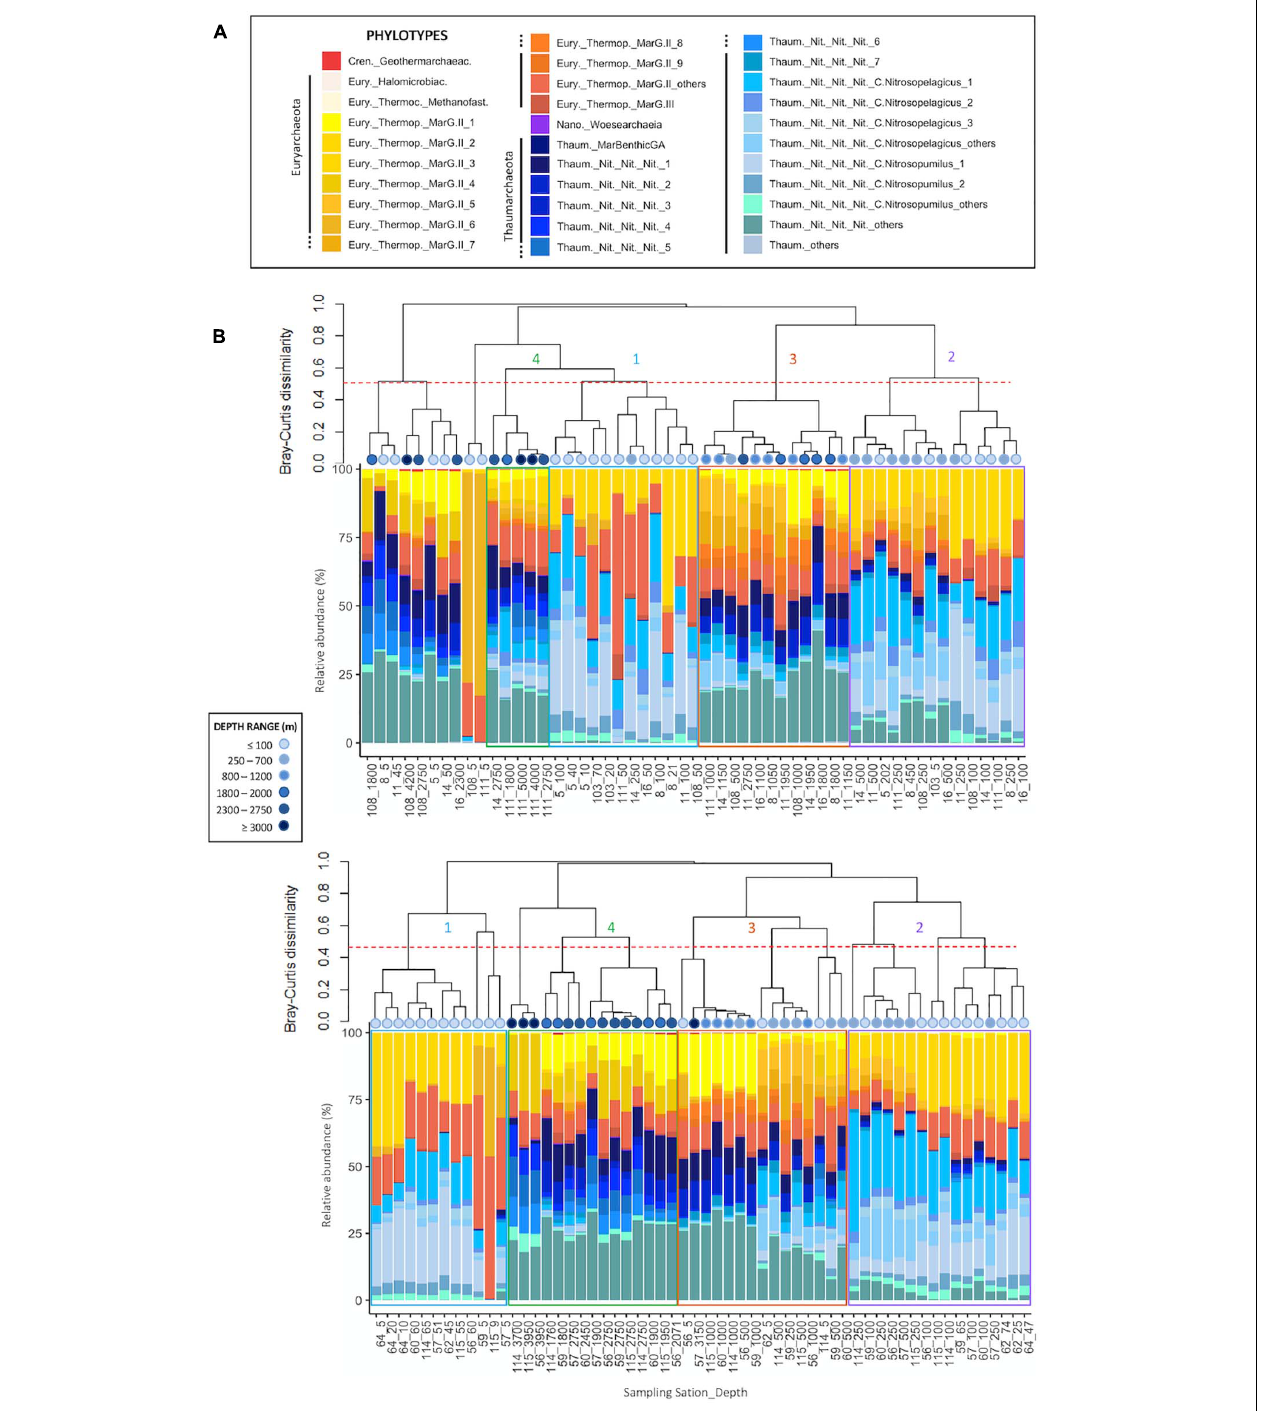
FIGURE 3 | Cluster dendrogram based on Bray-Curtis dissimilarity (after Hellinger transformation) among samples, associated to the plot of community composition in terms of the relative abundance (%) of abundant (relative abundance higher than 1% of total number of sequences in the dataset) Archaea phylotypes per sample for panels (A) Fisterra, and (B) Santander sections. Red-dashed line shows 50% of dissimilarity. Boxes help to visualize the 4 different clusters: cluster 1 = upper subsurface ( ≤ 100 m, blue); cluster 2 = lower subsurface (100-500 m, purple); cluster 3 = intermediate (500–2000 m, orange); cluster 4 = deep communities ( ≥ 2000 m, green). See Table 2 for further details on the taxonomy of abundant archaeal phylotypes. For comparative purposes, the same analysis, but constructed under the classical equal-taxonomic-level grouping approach, is shown in Supplementary Figure 9 .